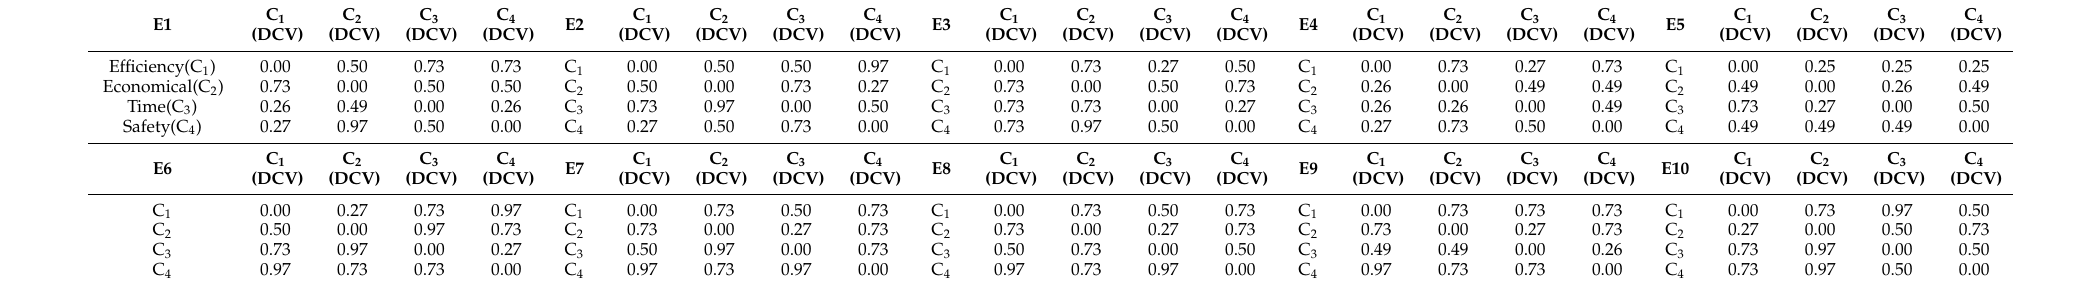
Table A11. The de-fuzzy crisp values for Triangle Fuzzy Numbers in Table